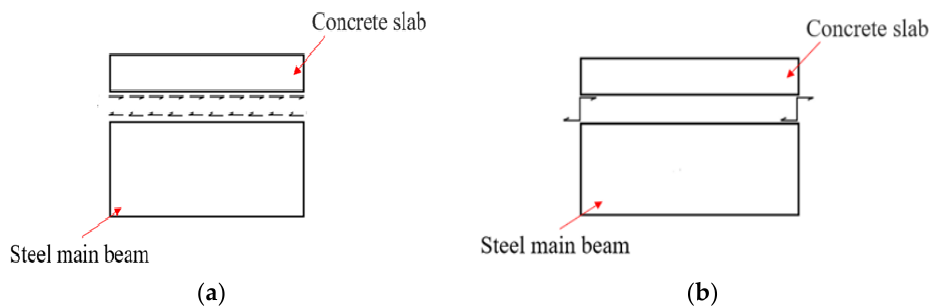
Figure 6. ( a ) Schematic diagram of combined section force transmission; ( b ) schematic diagram of double unit section force transmission.